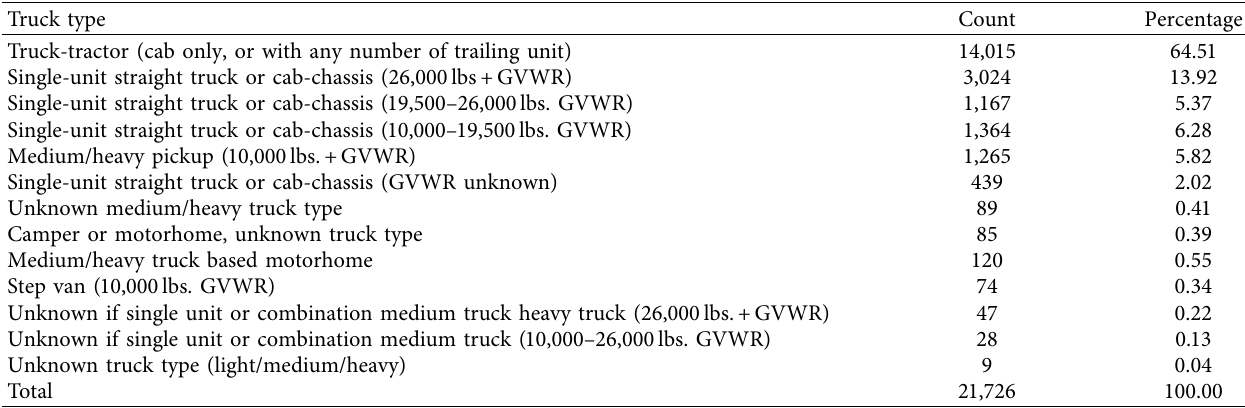
Table 1: Truck types and